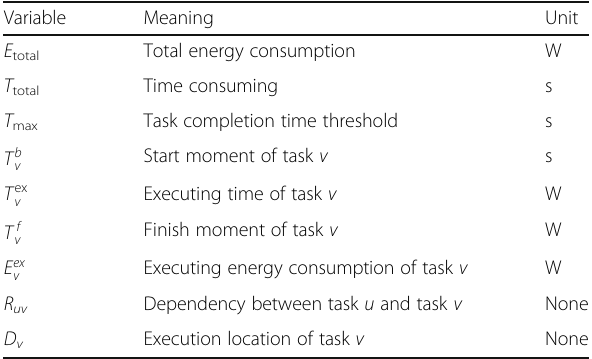
Table 2 Parameter table for minimization of